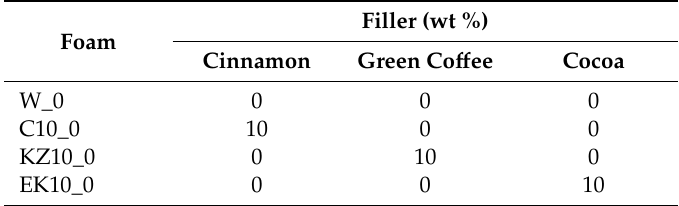
Table 2. Formulation of RPU / PIR